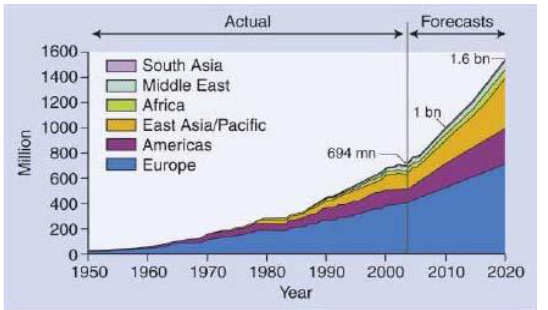
Figure 1. Travelers crossing international borders [10] What is the magnitude of travel related morbidity / mortality?